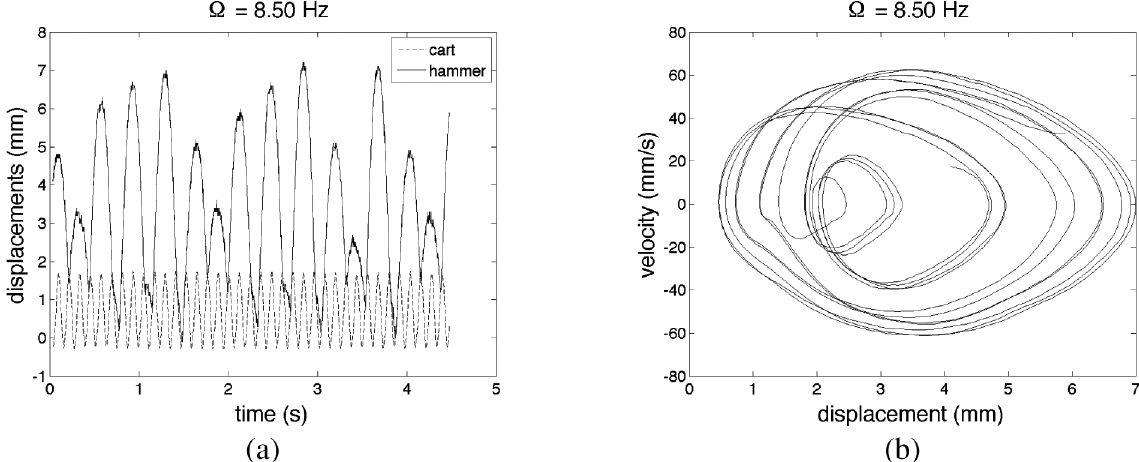
Fig. 9. Gap 0.0 mm. Nonperiodic behavior. Excitation frequency 8.50 Hz: a) Displacements; b) Hammer phase